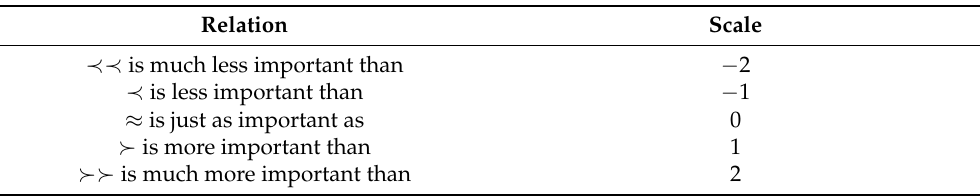
Table 2. Relationship and